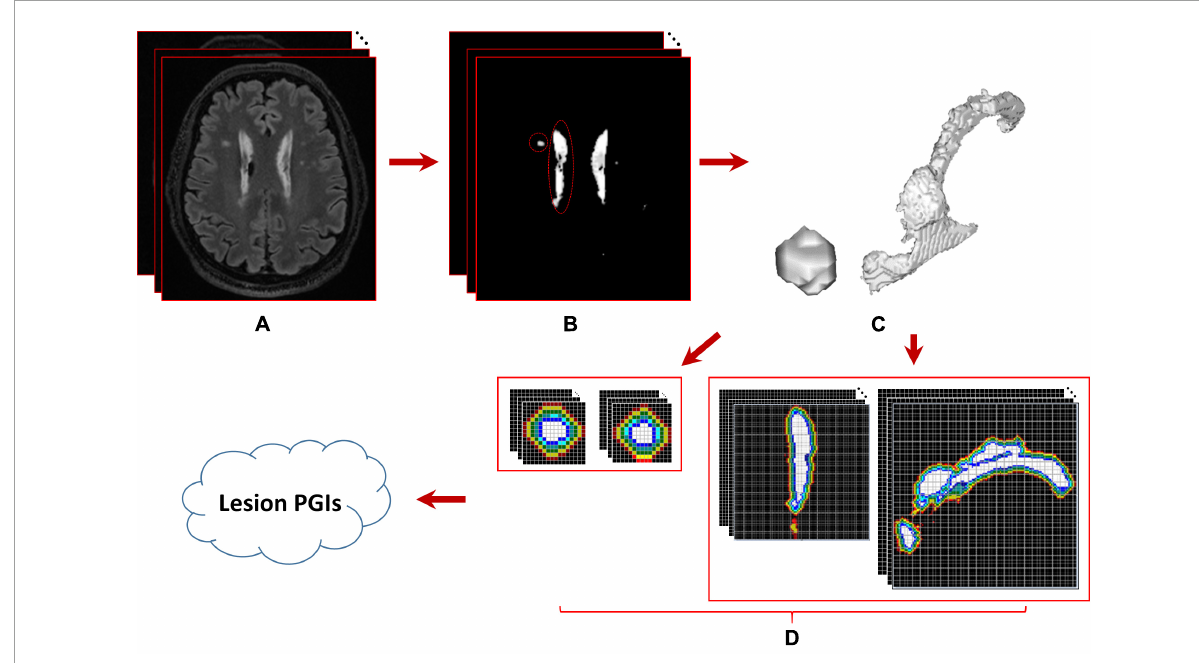
FIGURE7 Schematic analysis pipeline for calculating WMH3D potential growth index (PGI). (A) The 3D image volume of a subject, (B) the results of WMH segmentation using the lesion prediction algorithm, (C) two enlarged WMH3Ds whose locations are marked with red circles in panels (B,D) the intensities of potential penumbra voxels within the range of interest are displayed in a lighter color with two different viewing directions. The sizes of these two 3D lesions are 91 and 12409 voxels, respectively.